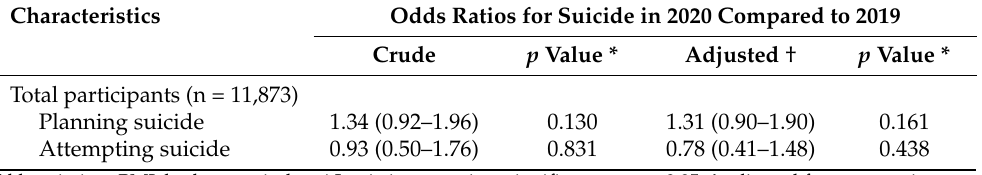
Table 4. Odds ratios (95% confidence intervals) for suicide (planning suicide, attempting suicide) in 2020 compared to